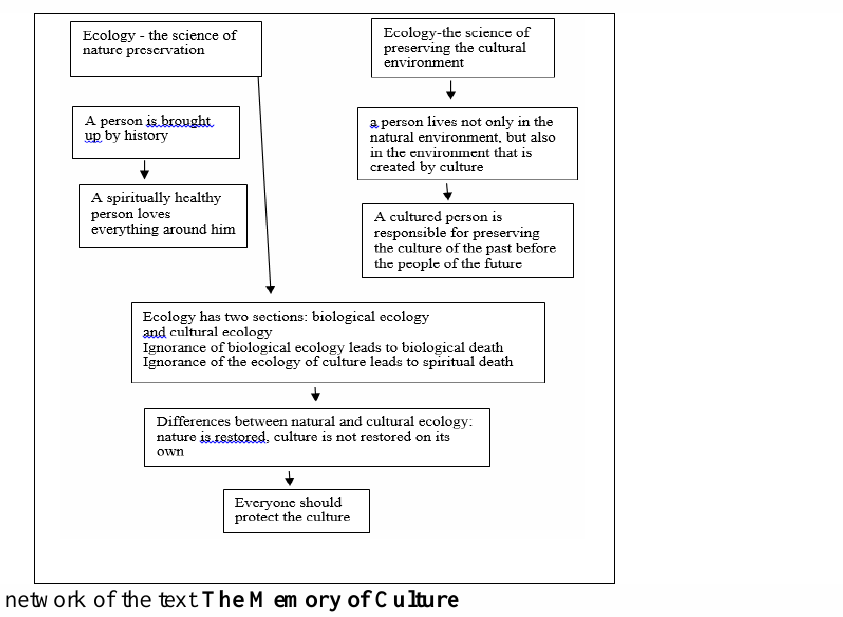
Fig. 2. Its Pathfinder network of the text The Memory of Culture Cloze